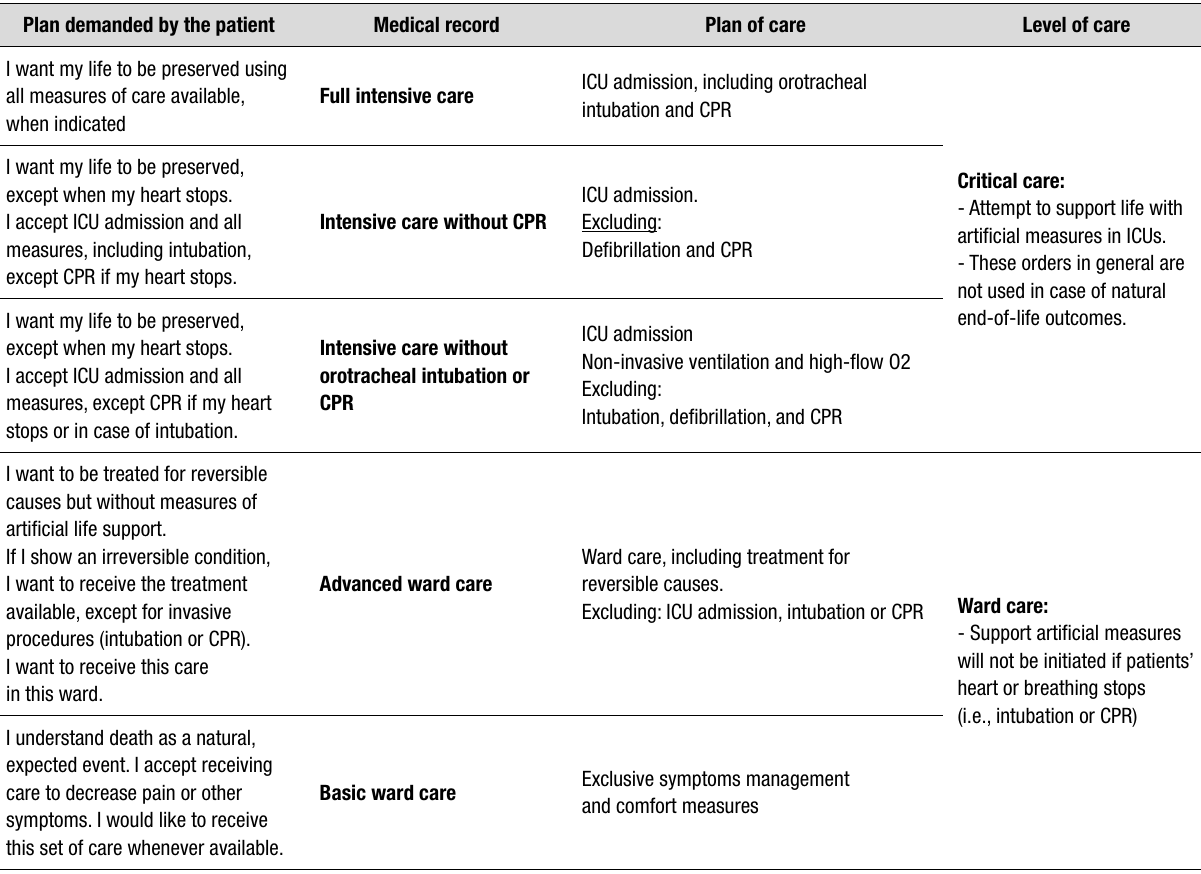
Table 7. Medical Orders for Scope of Treatment (MOST), in Portuguese, adapted to patients with end-of-life dementia stage. Staging must consider wishes to admission in a critical care unit, orotracheal intubation and cardiac resuscitation. Plan demanded by the patient Medical record Plan of care Level of care Full intensive care